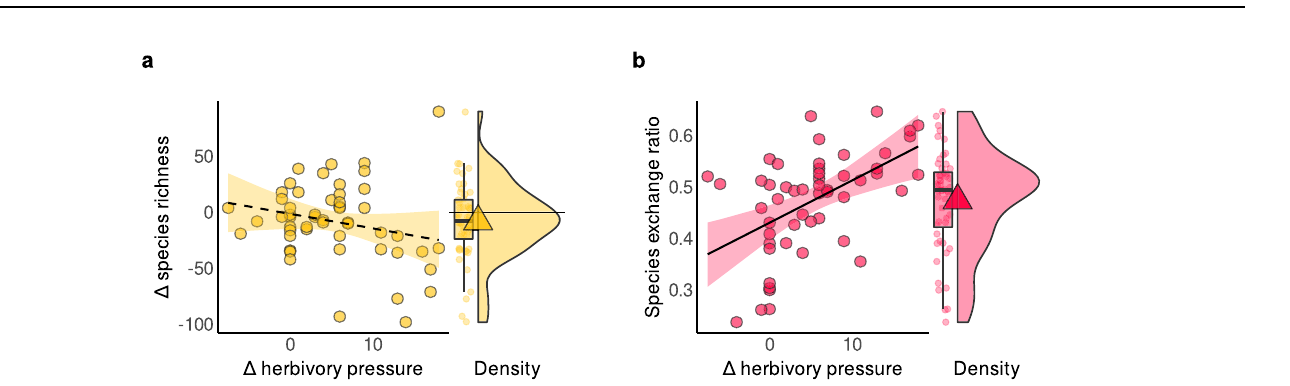
Fig. 2 | Higher herbivory decreased shrub layer cover, but not herb and tree layer cover. Relationships between changes in ( Δ ) herbivory pressure and a Δ shrublayercover, b Δ herblayercover,and c Δ treelayercover.Allmodelsincluded inter-census time span, site area, and baseline herbivory as covariates. Note two sites lacked shrub and tree cover and one site also lacked herb cover data so that therewere n =50and n =51independentresurveysitesfora,c,andb,respectively. Lines and ribbons represent the posterior mean line and the 95% credible interval.